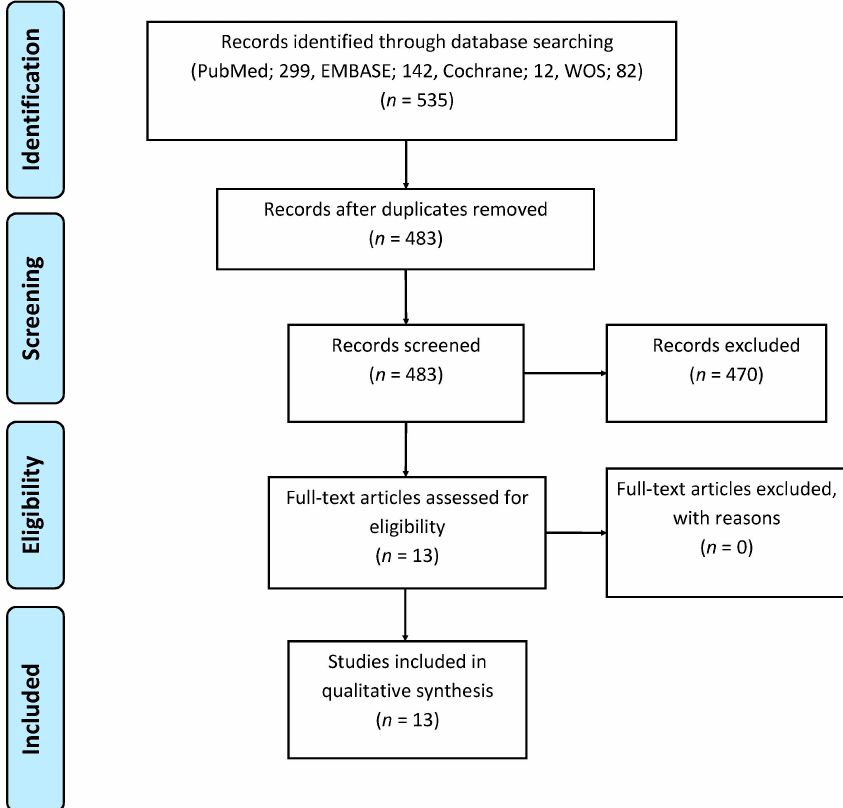
Figure 1. Flowchart of the literature search and study